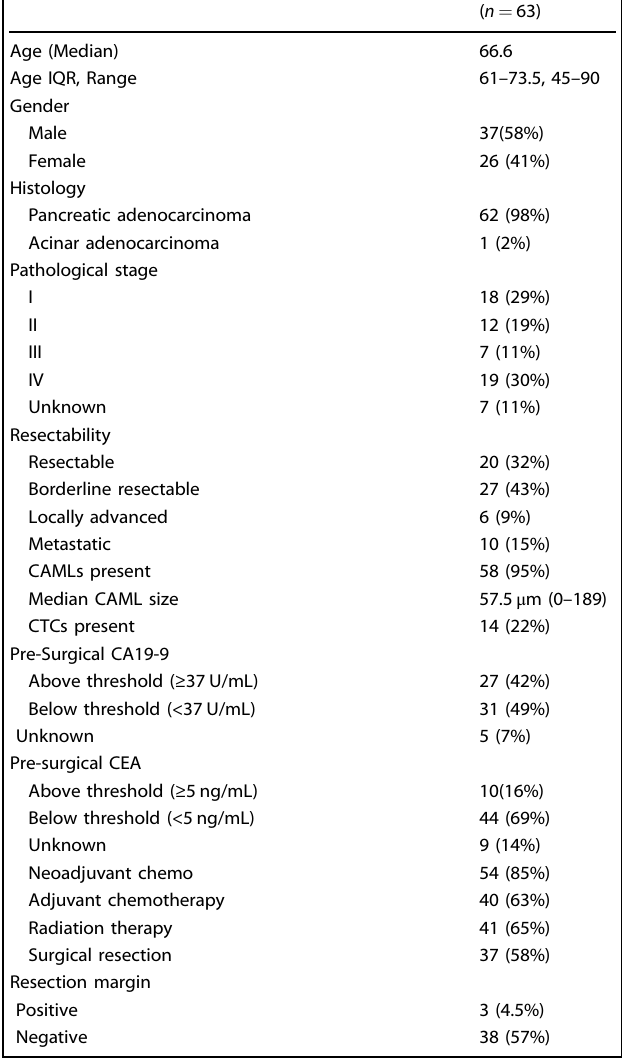
Table 1. Clinical demographic information for